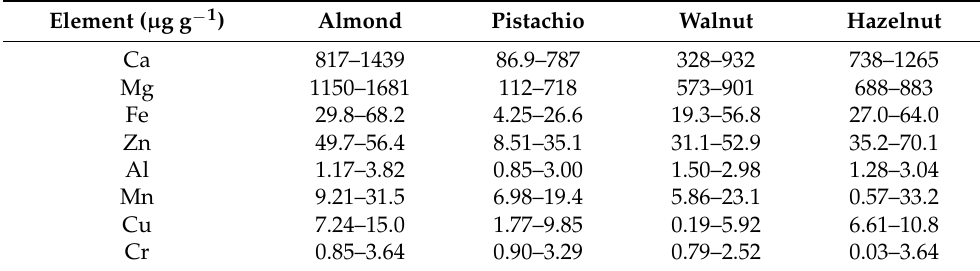
Table 2. Metal concentration ranges in nut samples of a Greek market.